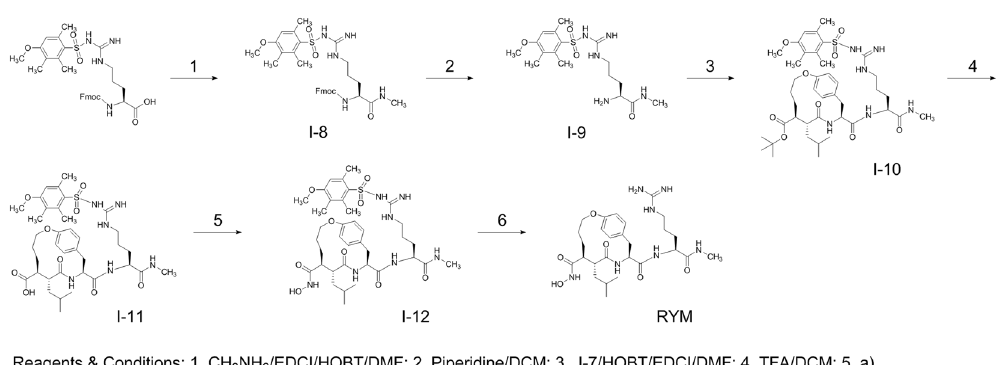
Figure 4. Synthesis of an Arg-containing anti-succinate-based macrocyclic hydroxamate,